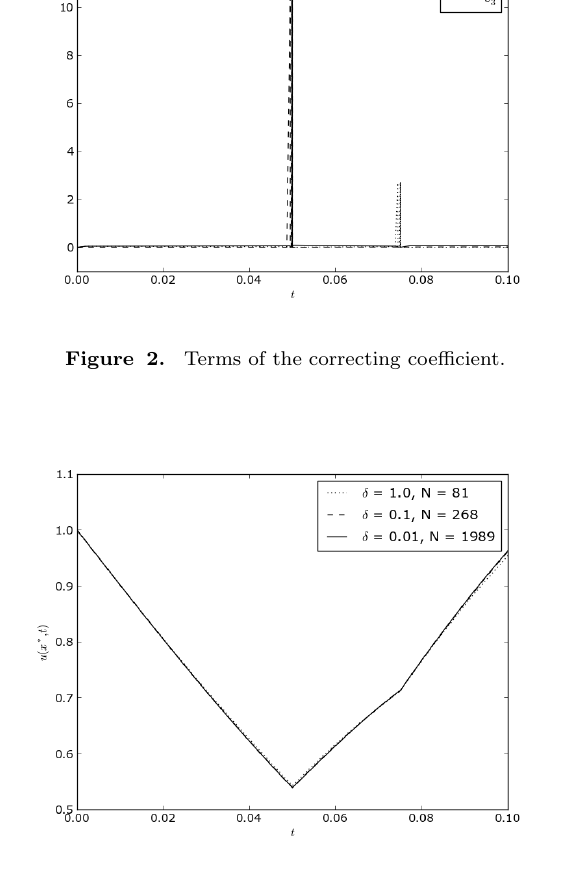
Figure 3. Approximate solution for various δ